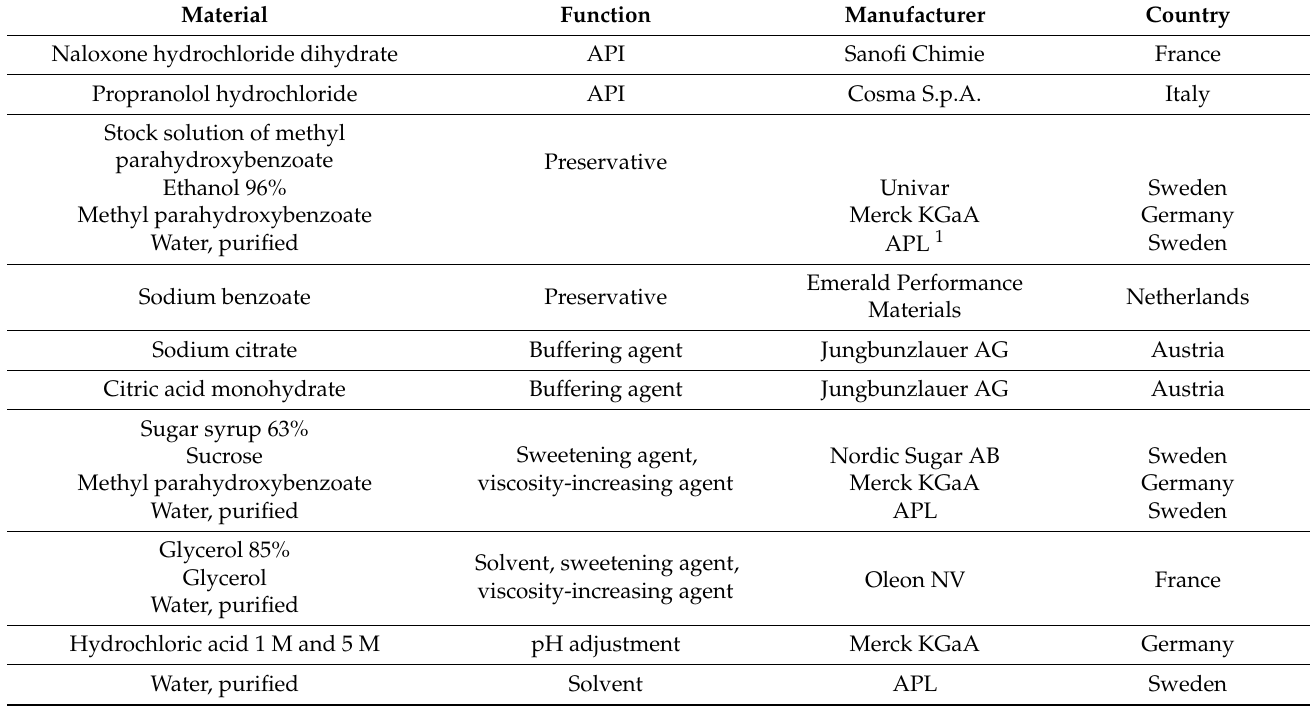
Table 2. An overview of the materials and their functions. API = Active pharmaceutical ingredient.